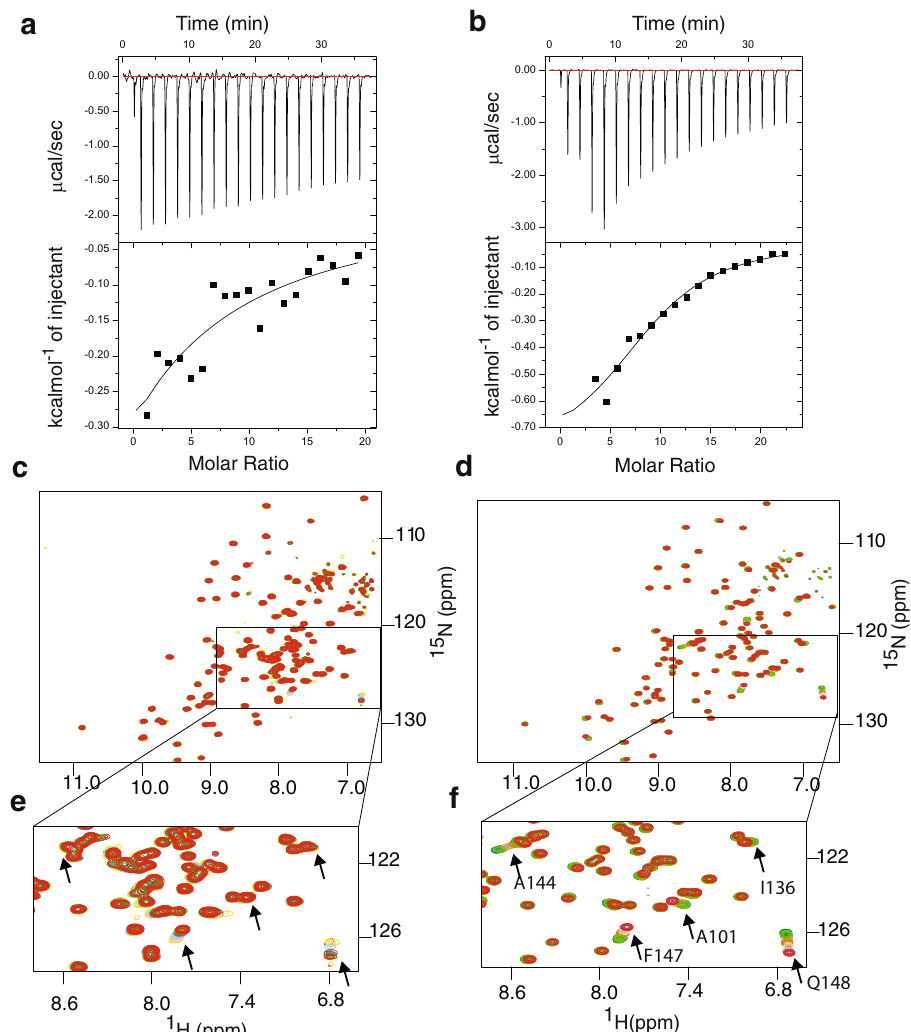
Fig. 4 Heimdallarchaeota pro fi lin interacts with polyproline. Isothermal titration calorimetric (ITC) binding measurements between heimPro fi lin ( a ) or Δ N-heimPro fi lin ( b ) with polyproline motif of VASP (GAGGGPPPAPPLPAAQ). The heimPro fi lin showed weaker binding strength compared to Δ N- heimPro fi lin which had a K D of 3.3 ± 1.8 mM and 0.3 ± 0.10 mM respectively. c , d Nuclear magnetic resonance (NMR) 1 H – 15 N chemical shifts for the binding reaction of a fi xed concentration of heimPro fi lin (200 μ M) and Δ N-heimPro fi lin (400 μ M) with increasing concentrations of polyproline from VASP (PPPAPPLPAAQ) respectively. For heimPro fi lin, the following VASP concentrations were used; 0 μ M (red), 100 μ M (light green), 300 μ M (green), 800 μ M (magenta), 1800 μ M (cyan), 2300 μ M (purple), 2800 μ M (yellow), and 3300 μ M (blue). For Δ N-heimPro fi lin; 0 μ M (red), 100 μ M (magenta), 500 μ